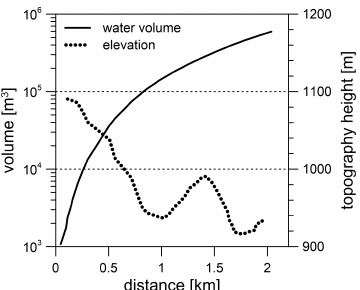
Figure 11. Estimation of the magnitude of water volume (black) capable of producing 1nrad tilt if it was purely Newtonian. The dotted line shows the cross section of the topography in the specific azimuth defined by the E–W and N–S tilts detected during rainfall events.